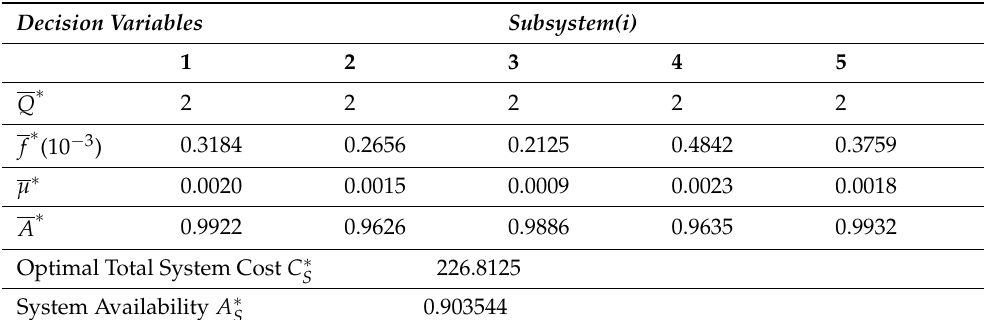
Table 34. Optimal Solutions obtained by MRAH–MGA for the n -stage q /2-out-of- q system. Decision